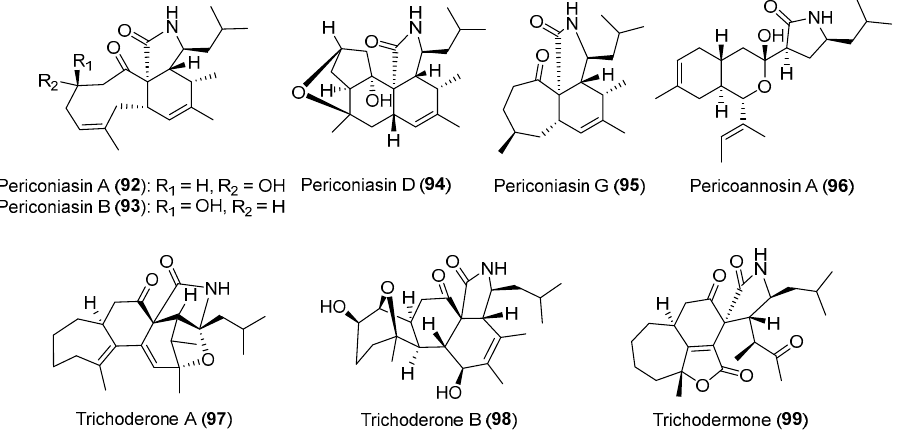
Figure 16. Structures of compounds 92 – 99 .